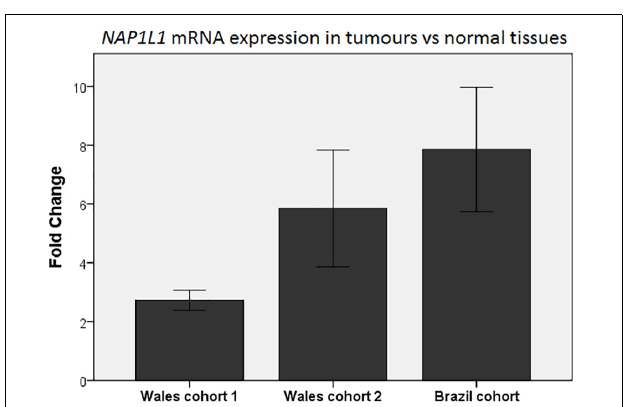
FIGURE 2 | qPCR analysis of NAP1L1 expression in CRC tumors presented as fold-change relative to normal tissues in different cohorts. Each column represents the relative quantification (fold-change) of NAP1L1 mRNA expression in CRC compared to the respective normal control (normal control expression mean = 1). Wales cohort 1, mean fold-change = 2.7; p < 0.05 (18 paired colorectal cancer and adjacent normal colonic tissue samples). Wales cohort 2, mean fold-change = 5.8; p < 0.001 (30 paired colorectal cancer and adjacent normal colonic tissue samples). Brazil cohort, mean fold-change = 7.9; p < 0.001 (10 normal samples from healthy individuals without colorectal neoplasia and 25 colorectal cancer samples). Mann–Whitney U test. Error bars: ± 1